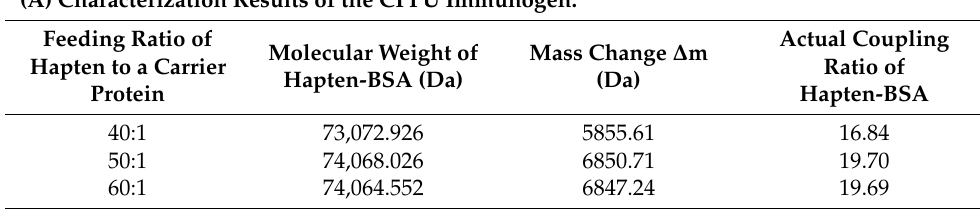
Table 1. Characterization of the CPPU immunogen and coating